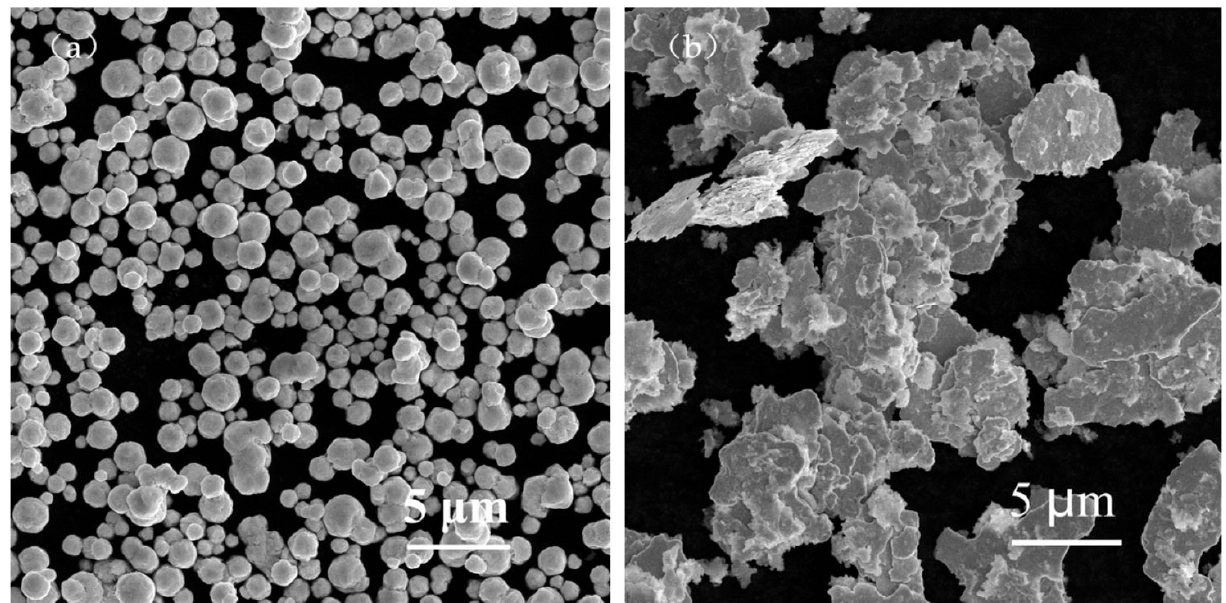
Figure 1. SEM images of the spherical silver powder and flake silver powder. ( a ) Spherical silver powder. ( b ) Flake silver powder.